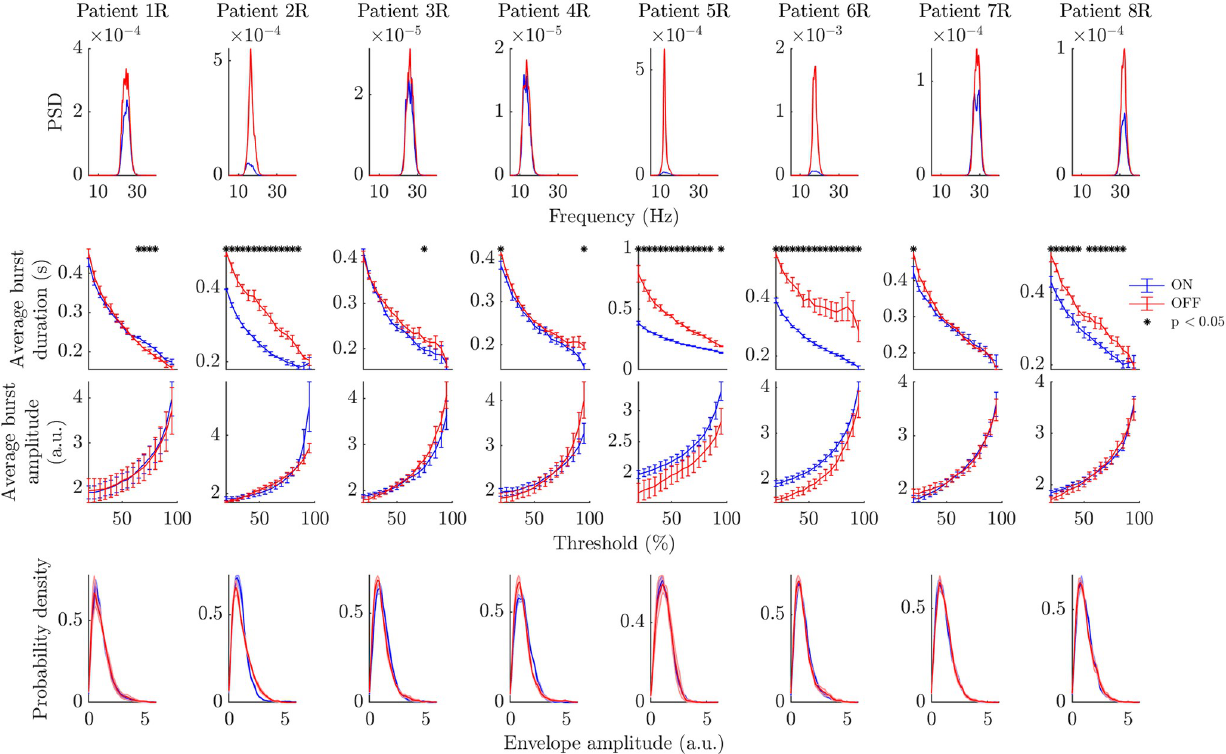
Fig 3. Power spectra and bursting features ON and OFF Levodopa (right hemispheres). Each column corresponds to the right hemisphere of one of the eight patients. Each row corresponds to a feature, the ON state is in blue, and the OFF state in red. The first row shows power spectra, the second row average burst duration profiles, the third row average burst amplitude profiles, and last row envelope amplitude PDFs. Statistically significant differences under FDR control are indicated by black stars (three bursting features only). Error bars represent the SEM.